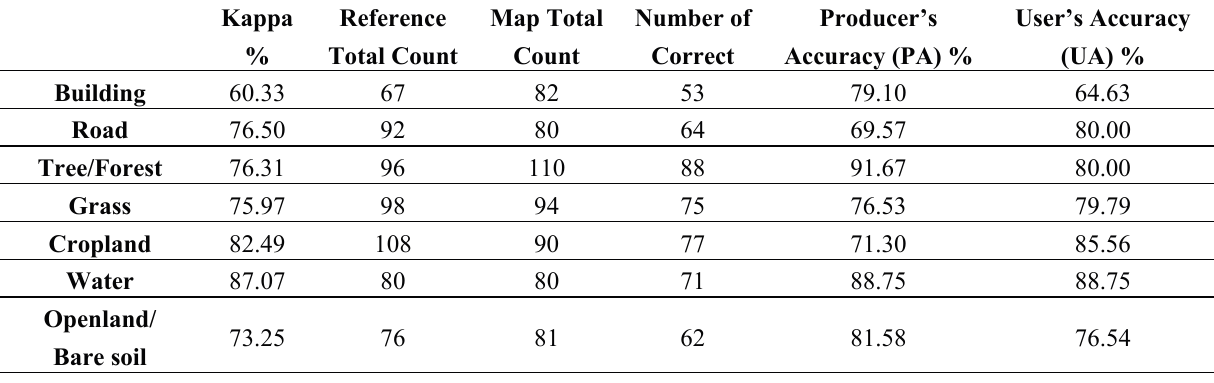
Table 6. Accuracy assessment on classification result using pixel-based